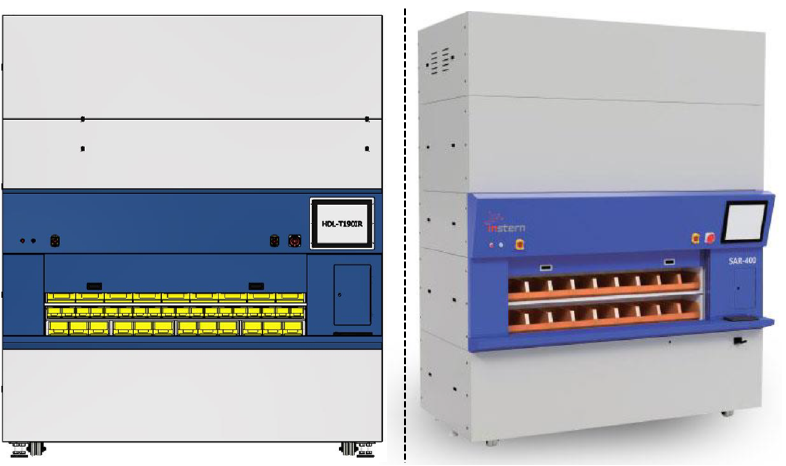
Figure 1. The front and side view of a vertical carousel module type of AS/RS